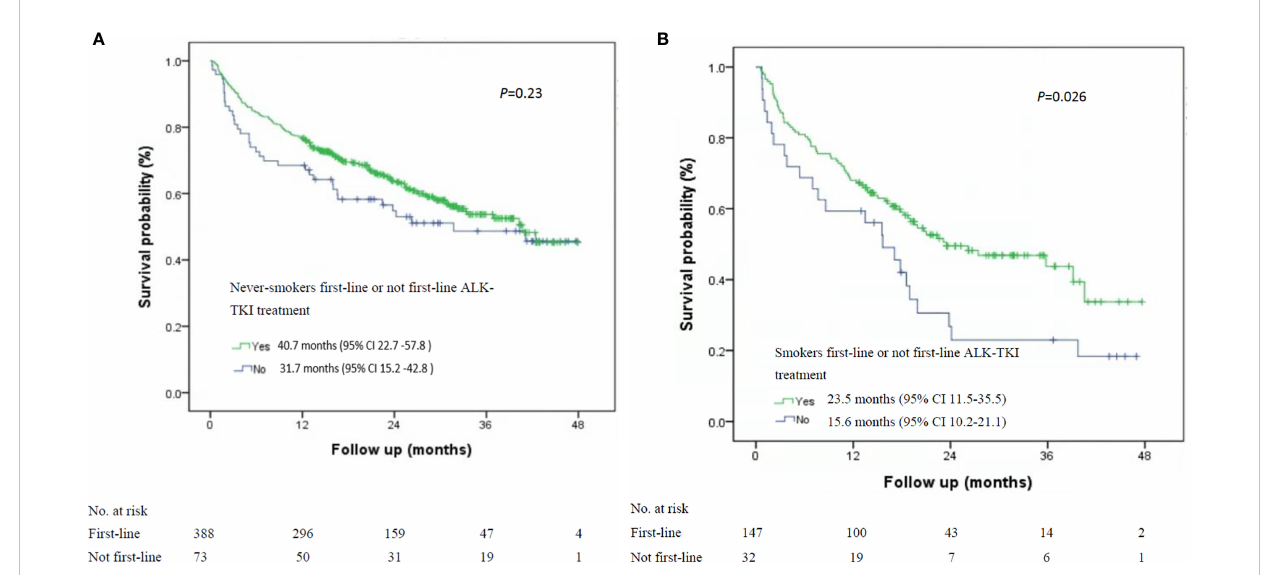
FIGURE 2 Kaplan-Meier curves of overall survival strati fi ed by smoking status and ALK-TKI treatment line in ALK-positive patients. (A) Never-smokers and fi rst- line or not fi rst-line ALK-TKI treatment (n=461). (B) Smokers and fi rst-line or not fi rst-line ALK TKI treatment (n=179). ALK-TKI, anaplastic lymphoma kinase tyrosine kinase inhibitors.